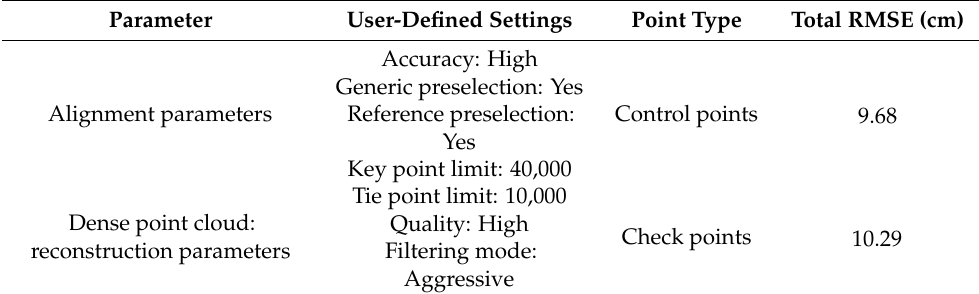
Table 3. User-defined settings used during the creation of VHR models (left) and reported RMSE in control and checkpoints (right). Parameter User-Defined Settings Point Type Total RMSE (cm) Accuracy: High 9.68Generic preselection: Yes Alignment parameters Control points Reference preselection: Yes Tie point limit: 10,000 Dense point cloud: Quality: reconstruction parameters